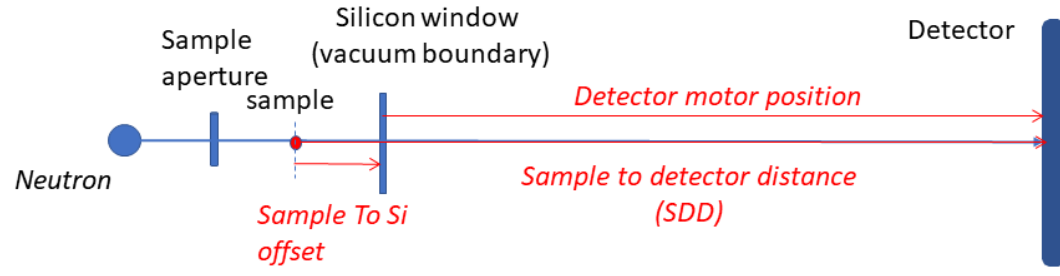
Figure 5. The diagram shows that the sample-to-detector distance combines the sample-to–silicon window offset and the actual detector motor position to form a controllable pseudo-motor.